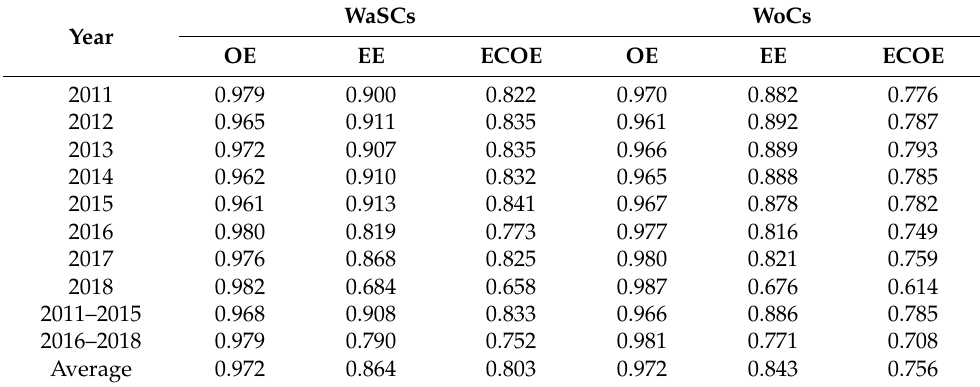
Table 2. Operational efficiency (OE) environmental efficiency (EE) and ecoefficiency (ECOE) for English and Welsh water and sewerage companies (WaSCs) and water only companies (WoCs). WaSCs WoCs Year EE